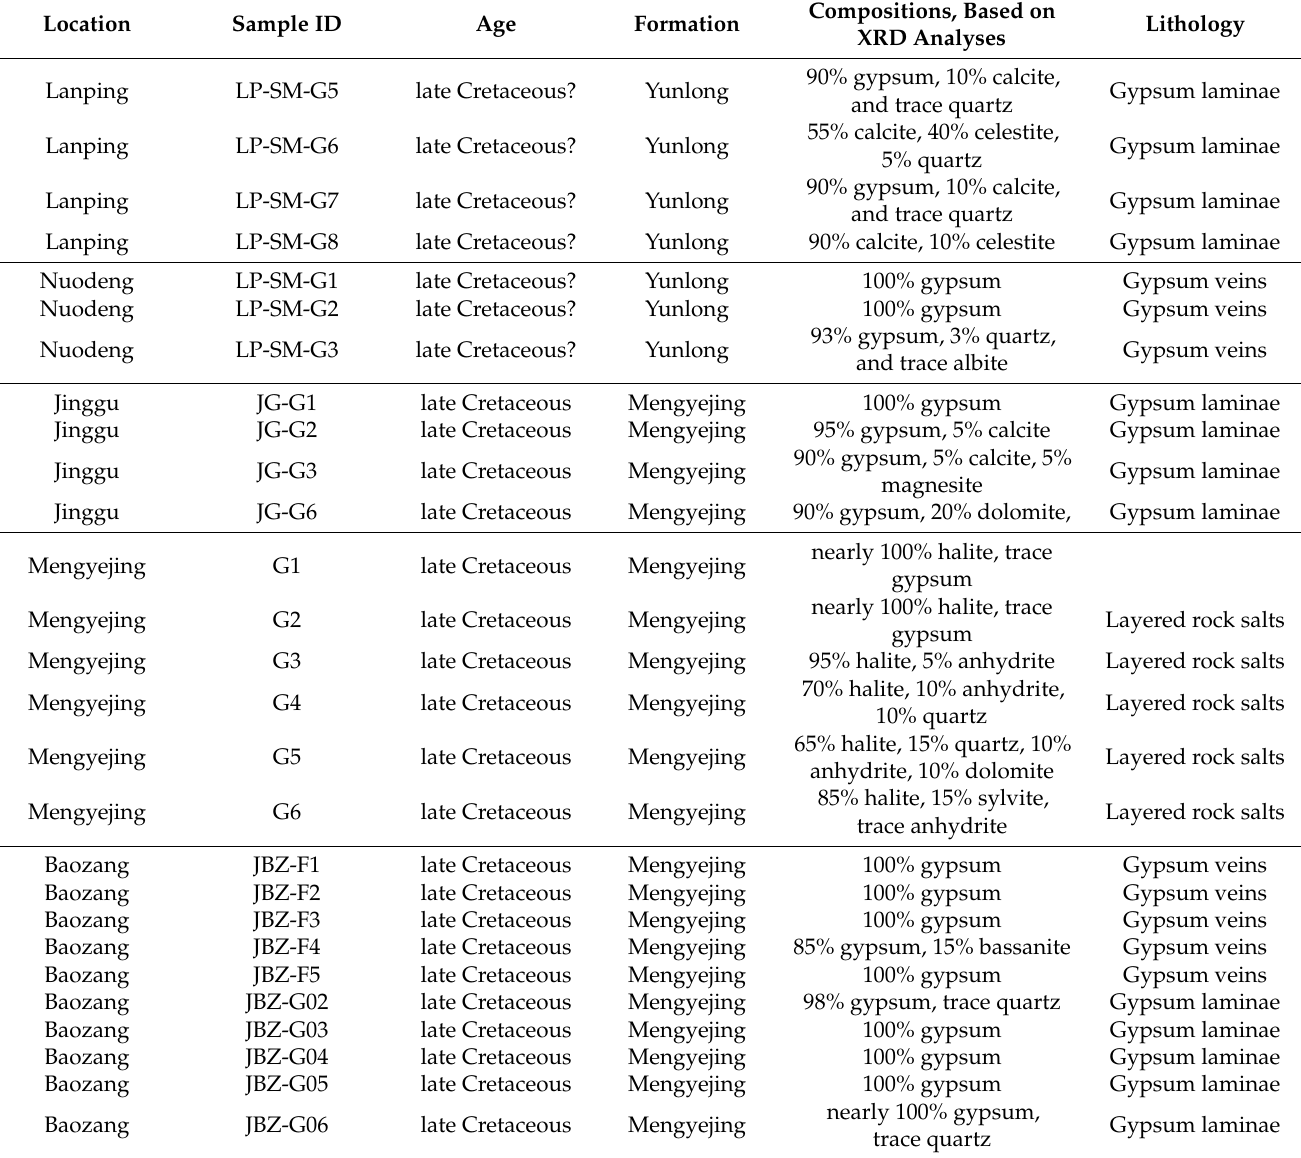
Table 1. Semi-quantitative X-ray diffraction (XRD) analyses of samples from different locations.